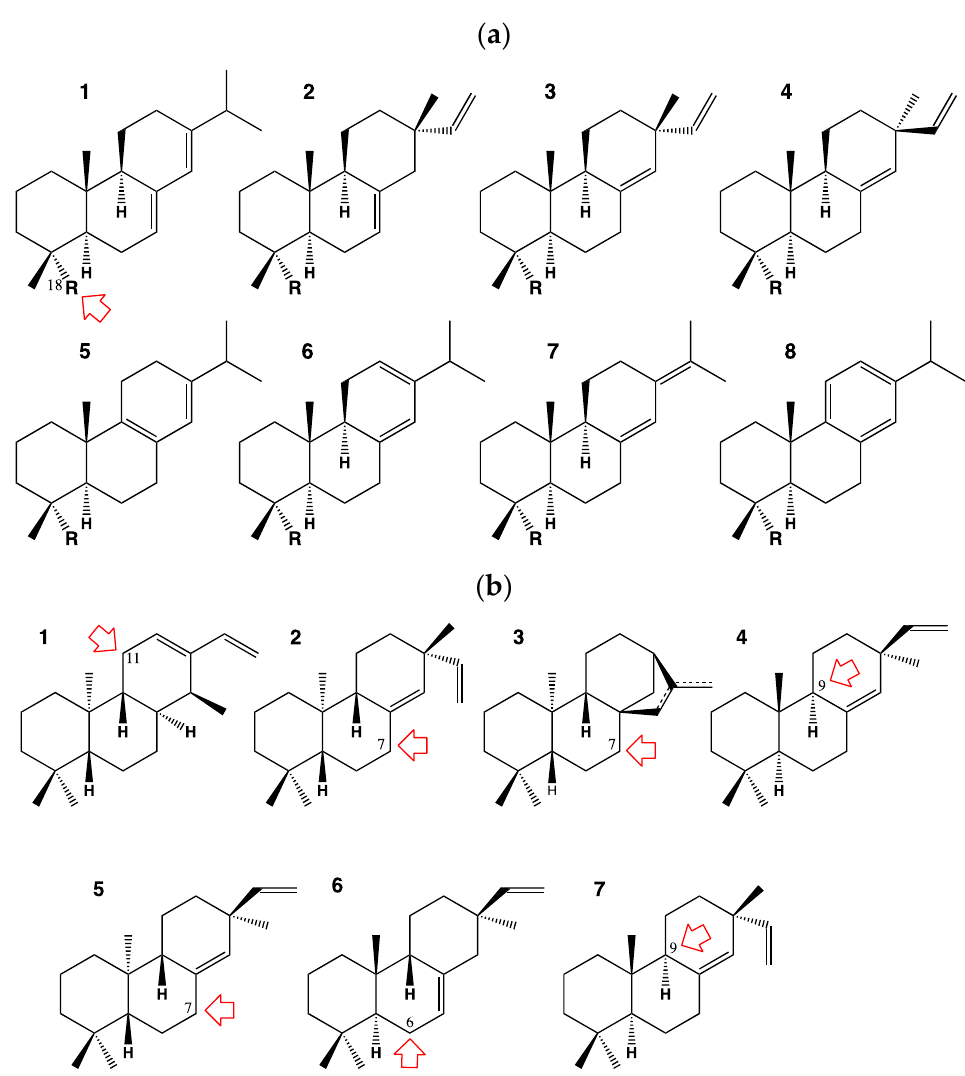
Figure 1. First examples of CYP promiscuity reported in the diterpenoid metabolism: ( a ) Diterpenoid substrates of CYP720B4 of sitka spruce. All compounds are attacked on C18 whether as methyl, alcohol, aldehyde substituent: 1: abietadiene; 2 : isopimaradiene; 3 : sandaracopimaradiene; 4 : pimaradiene; 5 : palustradiene; 6 : levopimaradiene; 7: neoabietadiene; 8 : dehydroabietadiene. ( b ) Diterpenes susbstrates of CYP76M8 of rice. Position of oxidative attack on each compound is numbered and indicated by the red arrow. Via these reactions CYP76M8 contributes to the phytocassane, oryzalexin and momilactone pathways: 1 : ent -cassa-12,15-diene; 2 : ent -pimara-8(14),15-diene; 3 : ent -(iso)kaurene; 4 : pimara-8(14),15-diene; 5 : ent -sandaracopimaradiene; 6 : syn -pimara-7,15-diene; 7 : sandaracopimaradiene.